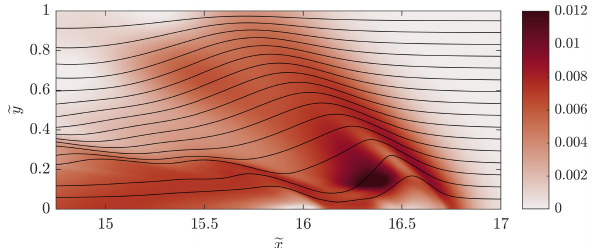
Figure 8. Density anomaly, e ρ , at e t = 5 . 2 (t = 50s ) and (a) e y = 0, (b) e x = 8 . 8, (c) e x = 8 . 9, and (d) e x = 9 for case